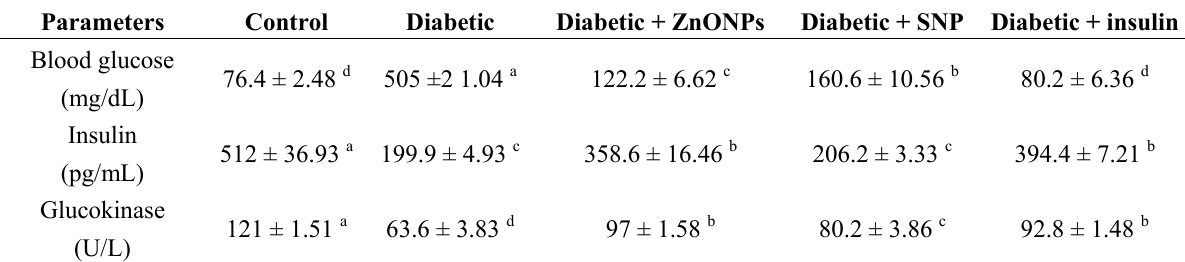
Table 1. Biochemical effect of zinc oxide, silver nanoparticles and insulin treatment on streptozotocin-induced diabetic